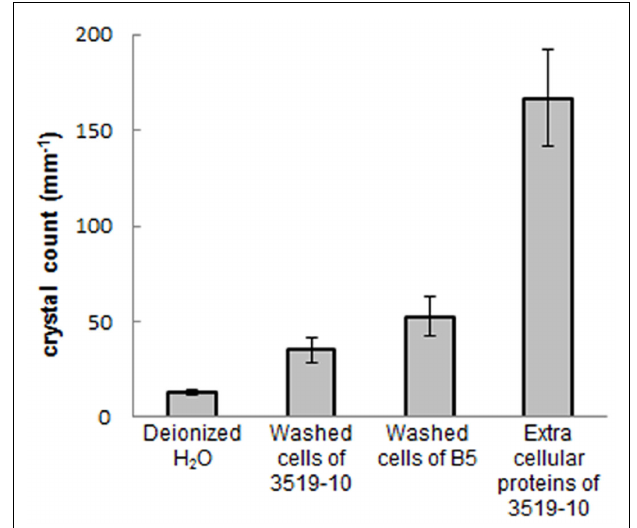
FIGURE 6 | Number of crystals per square millimeter for each ice sample (error bars are 1 σ ). From left to right: ices made with filtered deionized water, washed 3519-10 cells, washed Paenisporosarcina isolate B5 cells, and 3519-10’s extracellular proteins.